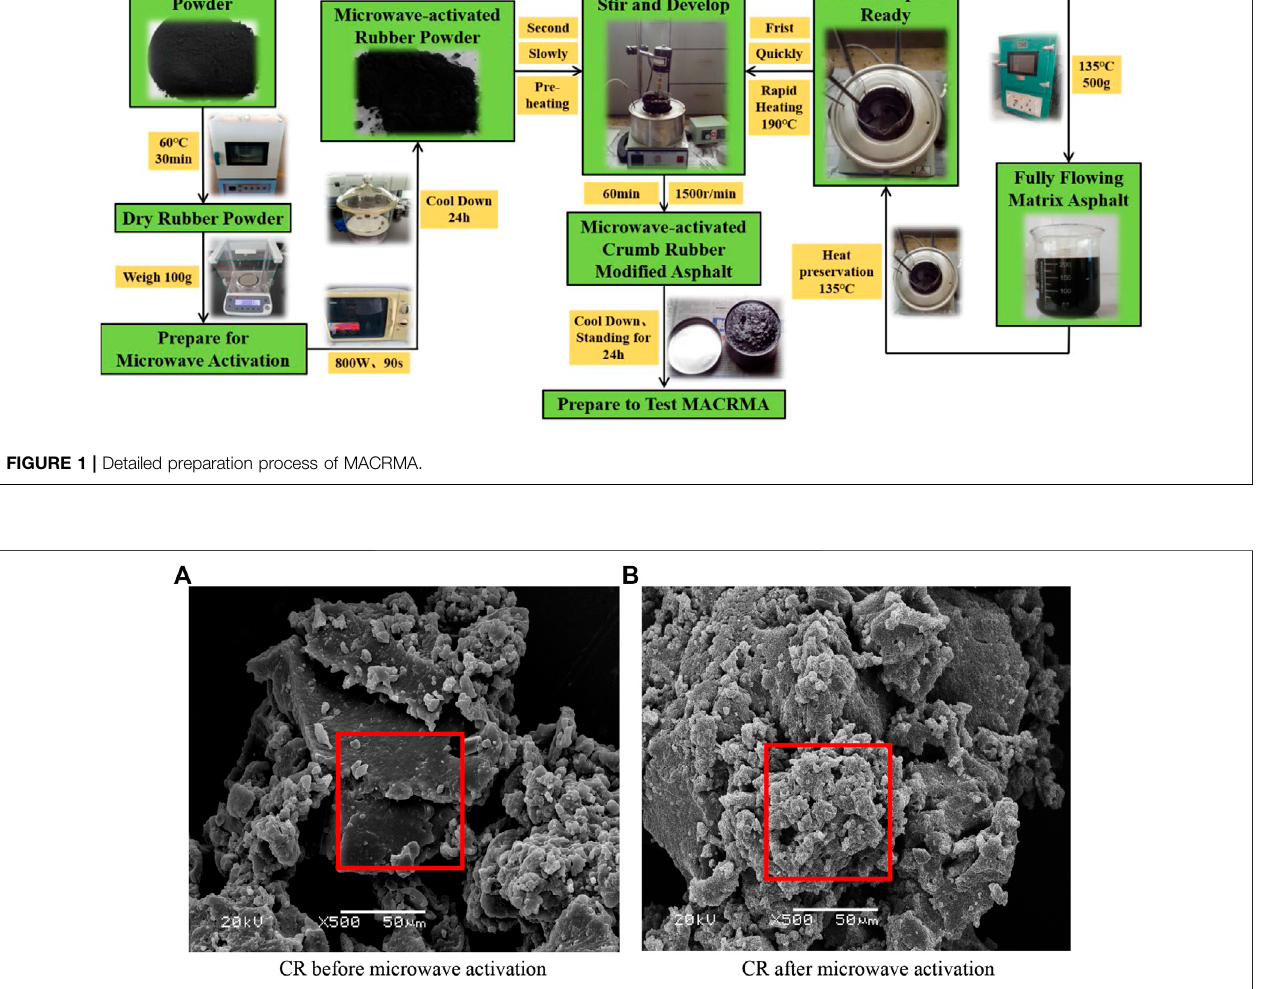
FIGURE 2 | SEM images of CR before and after microwave activation. (A) CR before microwave activation (B) CR after microwave activation.